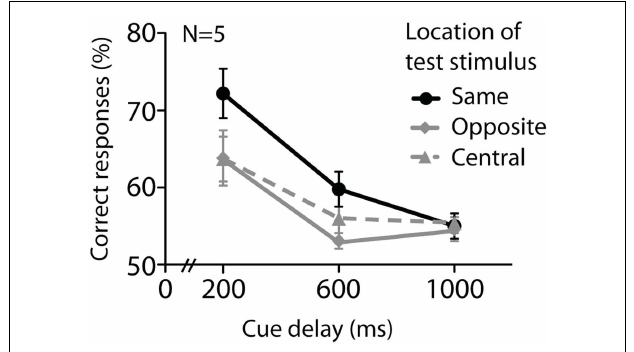
FIGURE 5 | Experiment 3 investigated the effect of test stimulus location on performance for orientation stimuli only, at 200, 600, and 1000ms. The test stimulus could be presented either at the same, central, or opposite location to the cued one. Performance decreased over time and was worsened if the test stimulus was presented at a central or opposite location. Error bars denote standard errors of the mean, N =